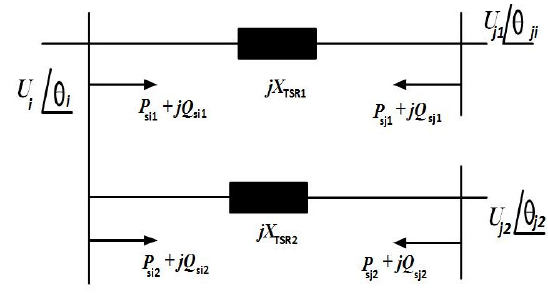
Fig. 7: The Injection Model of an IPFC with Two Series Branches